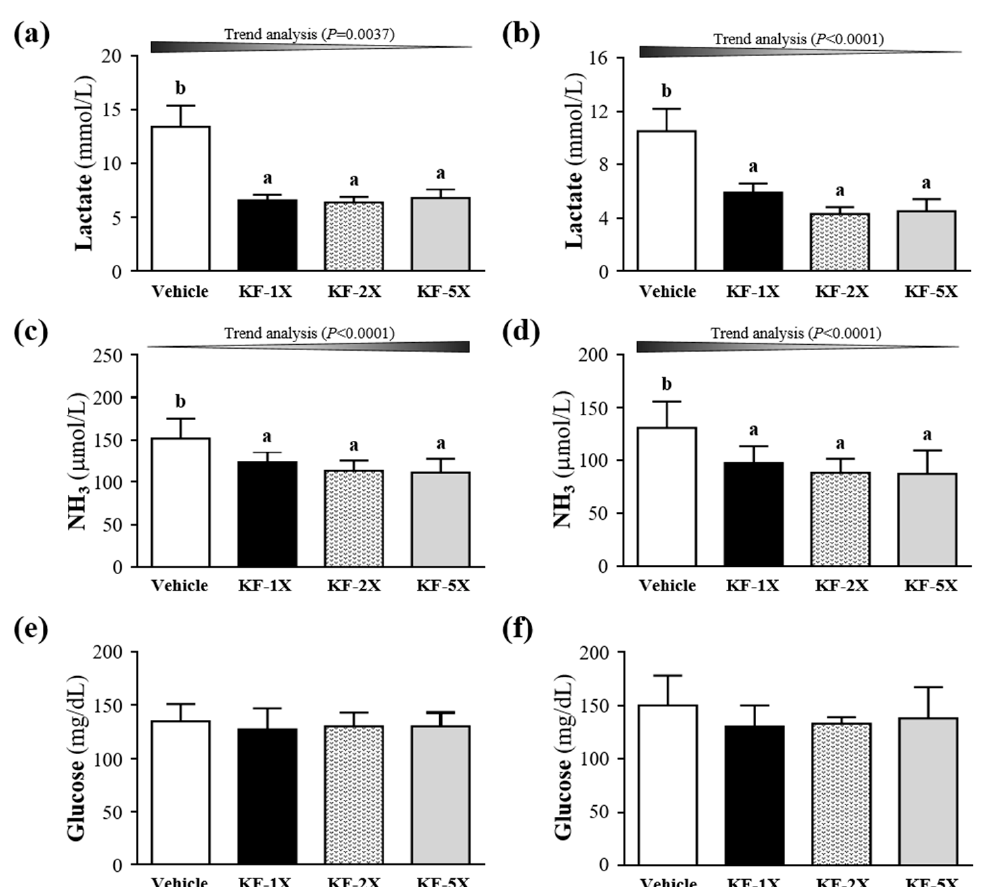
Figure 2. Effects of kefir (KF) supplementation on the forelimb grip strength. Data are presented as mean ± SD, n = 8. Bars with different letters ( a , b ) indicate a significant difference at p < 0.05 determined using one-way ANOVA. Vehicle (glucose water), KF-1X (2.15 g/kg/day KF), KF-2X (4.31 g/kg/day KF), and KF-5X (10.76 g/kg/day KF).